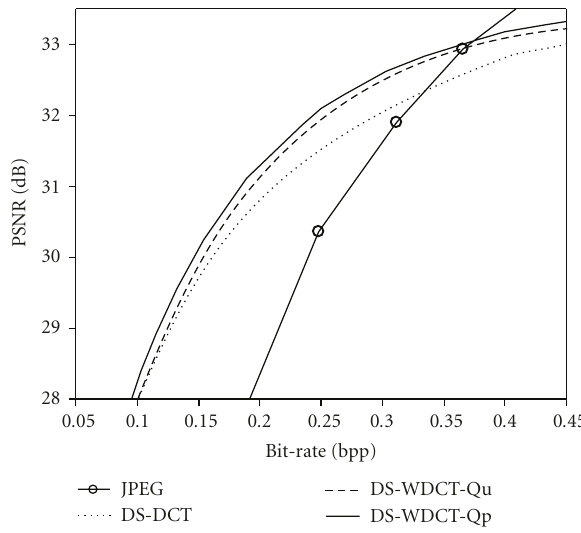
Figure 4: PSNR versus bit-rate for the Lena image of size 512 × 512.